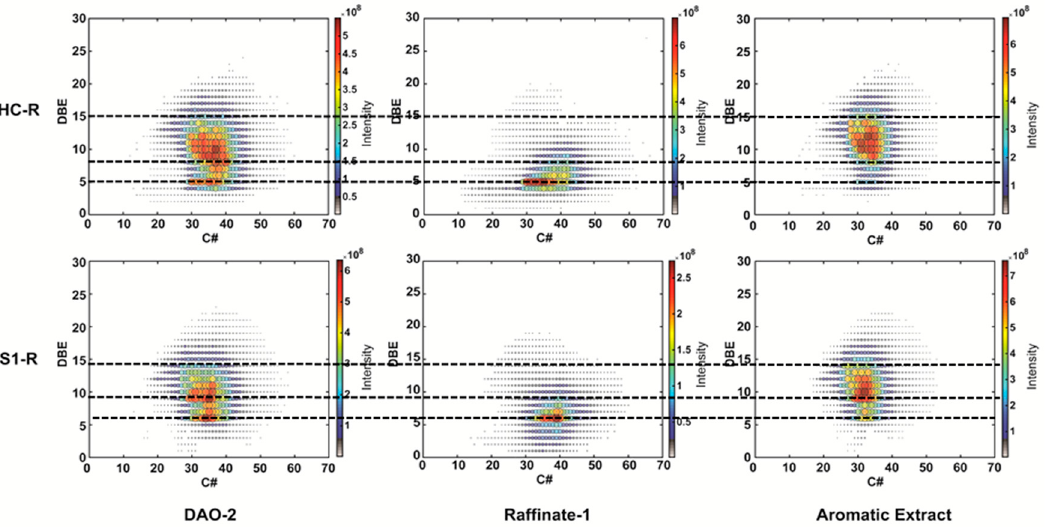
Figure 8. DBE/C# maps of the HC and S 1 chemical classes of the radical species detected by APPI+ in DAO 2, raffinate 1, and aromatic extract for the FF unit.